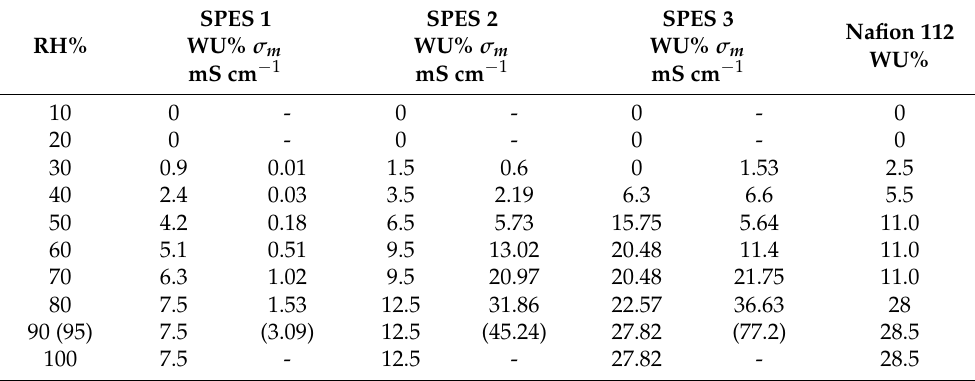
Figure 6. ( A ) Measured ionic conductivity as a function of relative humidity, RH, at T = 80 ◦ C of the SPES membranes. The data corresponding to Nafion 212 are also included for comparison purposes [20,69–71]. ( B ) Computed global ionic conductivity of the membranes (colored symbols) as a function of the ratio φ wr / φ max wr ( (cid:39) RH ) . The experimental data (black symbols) are included for comparison purposes. Table 2. Water uptake, WU%, and ionic conductivity, σ , of the SPES membranes and Nafion 112 at 80 ◦ C and different RH%. As indicated in brackets, the last measurement of the ionic conductivity was performed at RH% =